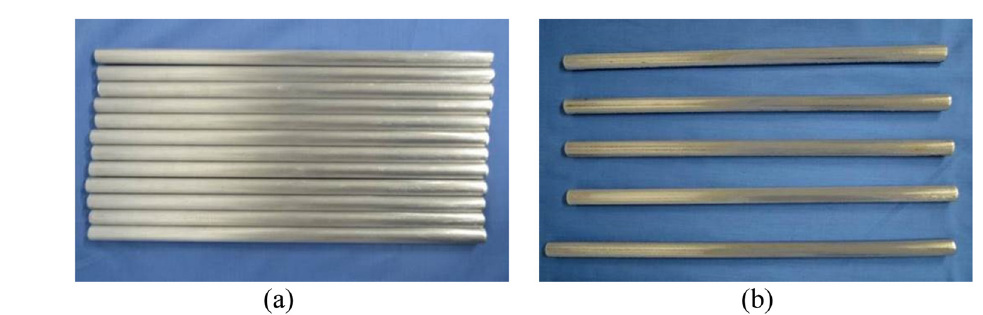
Figure 1: Specimens used in this study: ( a ) 6061 - T6 aluminium alloy and ( b ) HPB300 steel bar.